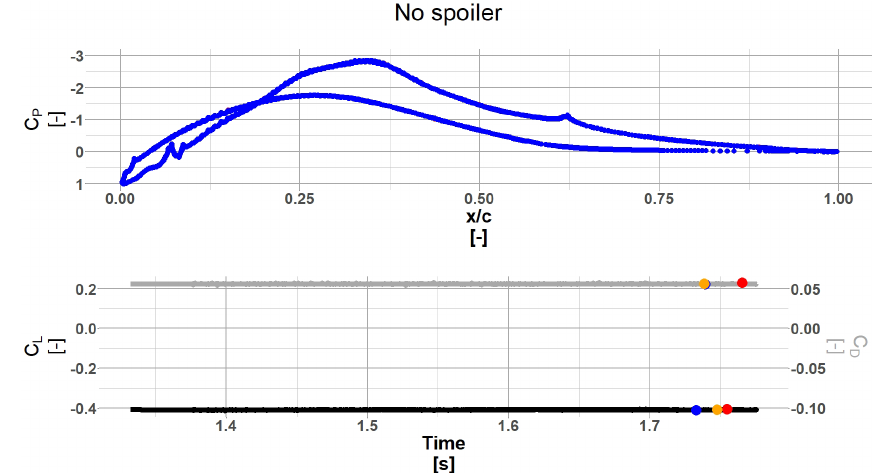
Figure 9. No spoiler case C p and aerodynamic coefficient evolution in time α = 6 ◦ and Re c = 3 × 10 6 . For both the C p and C L /C D plot, the blue dot (blue • ) corresponds to the minimum C L , and the red dot (red • ) corresponds to the maximum C L . In the C L /C D plot the orange dot (orange • ) corresponds to the mean C L .